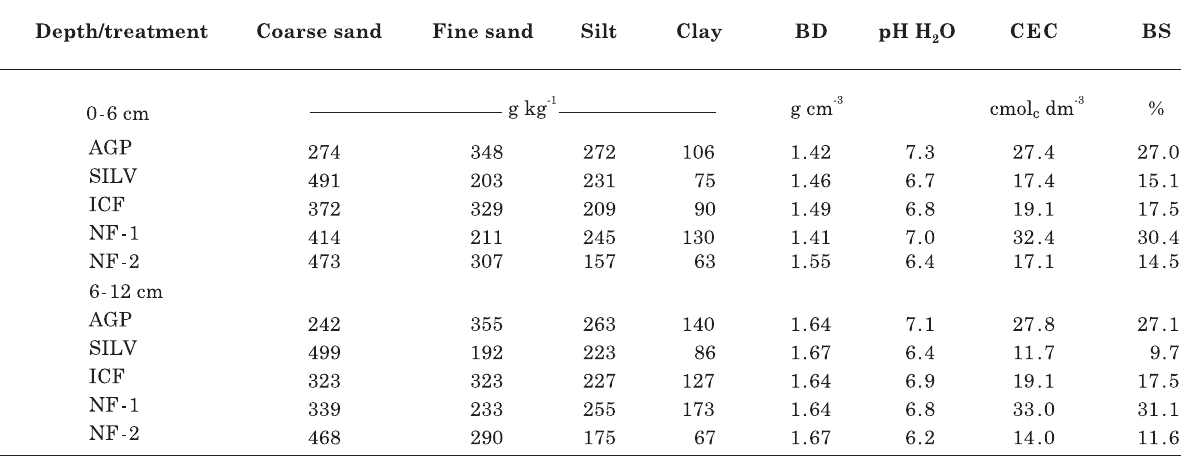
Table 1. Selected physical and chemical properties of a Chromic Luvisol in the 0–6 and 6–12 cm layers under agroforestry, intensive cultivation, and native